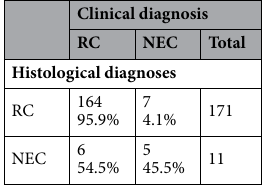
Table 1. Relationship between clinical and histological diagnoses of RC and NEC. RC radicular cysts, NEC non-endodontic cysts.